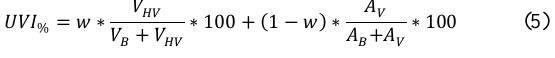
Figure 2. OBIA classification result – vector layer representing land cover classes as a base for calculating the spatial